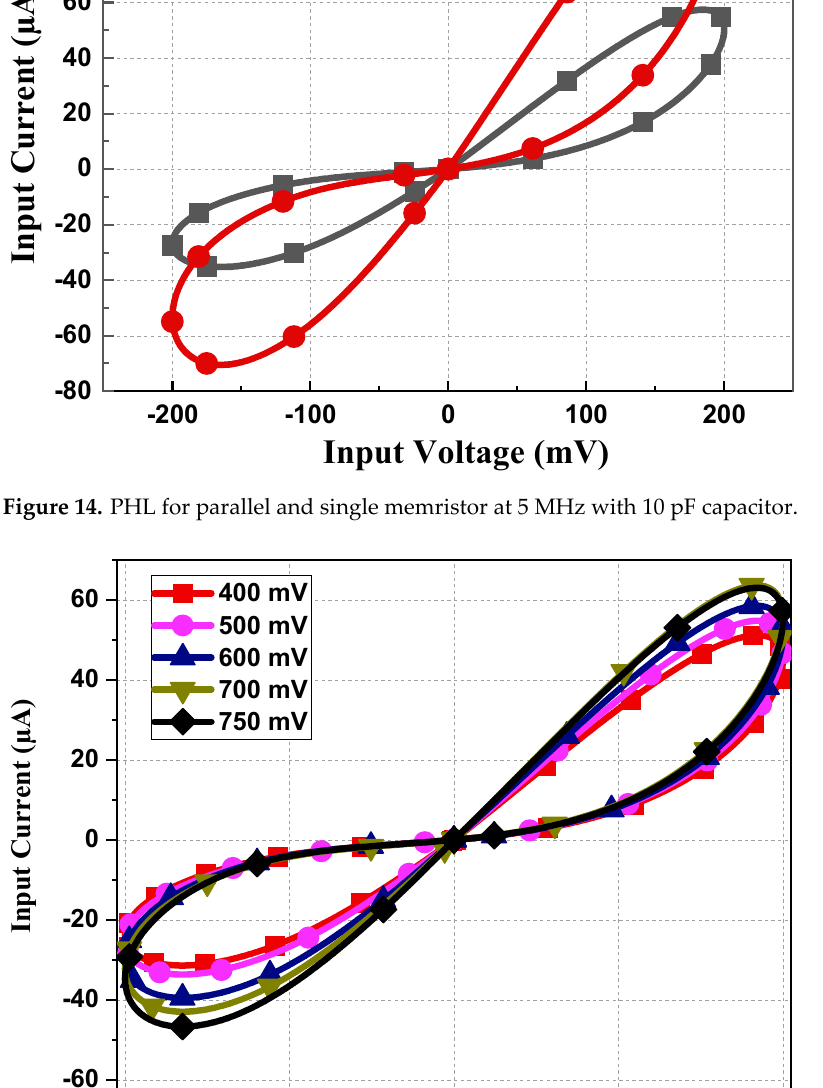
Figure 15. PHL for different values of V P at 5 MHz with 10 pF capacitor value. To reflect the memory effect of the memristor, the non‑volatility test was performed for both configurations. To achieve non‑volatility, we took a 200‑mV pulse with a 5 ns period and 0.5 ns ON time. The capacitor value taken for the non‑volatility test was 5 pF. Figure 16 a,b shows the non-volatility test for incremental and decremental configura- tions, respectively.